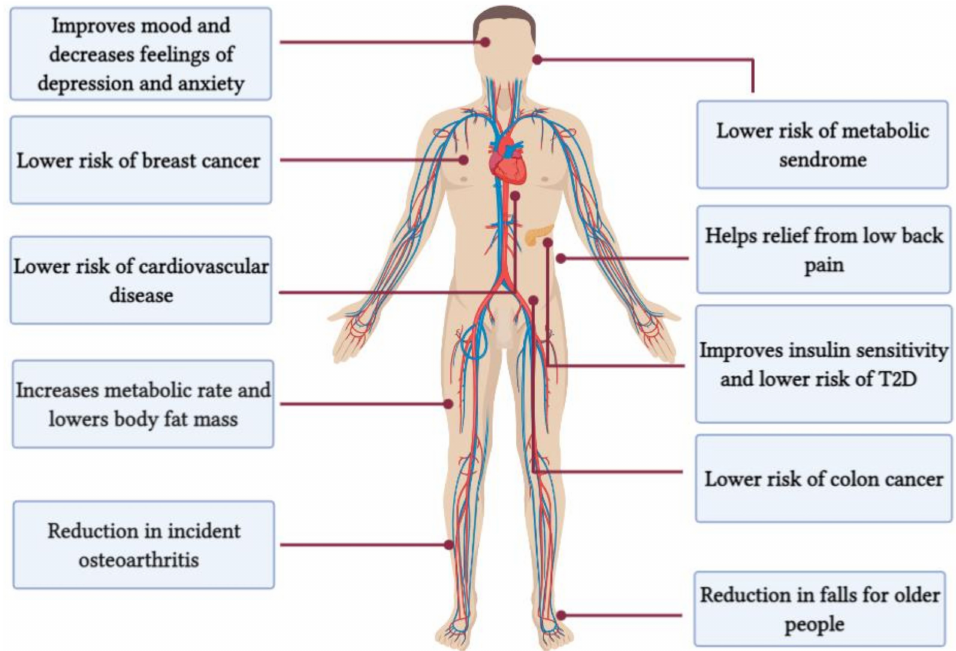
Figure 1. Documented health benefits of high-intensity interval